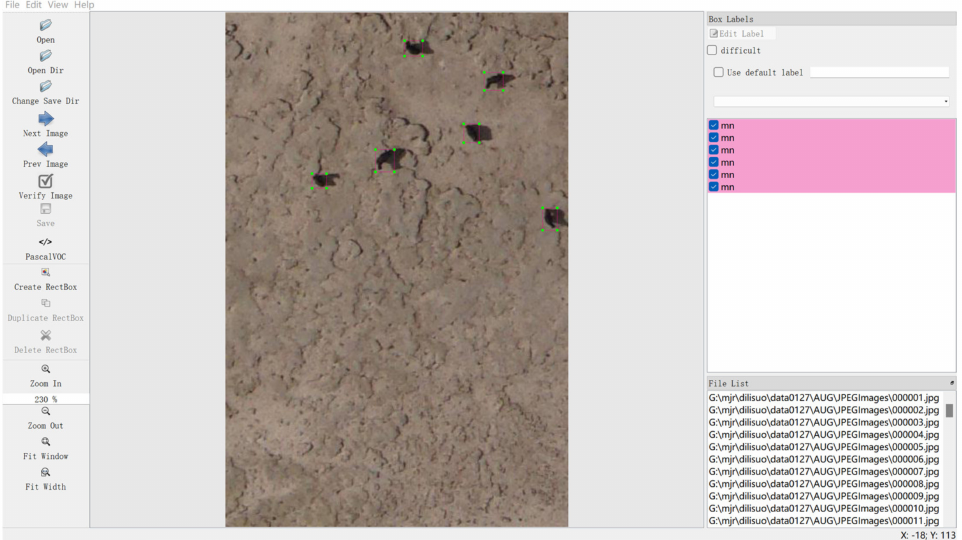
Figure 2. Diagram of the training sample creation process (the boxes composed of green points and red lines are the ground truth frames of large herbivores we